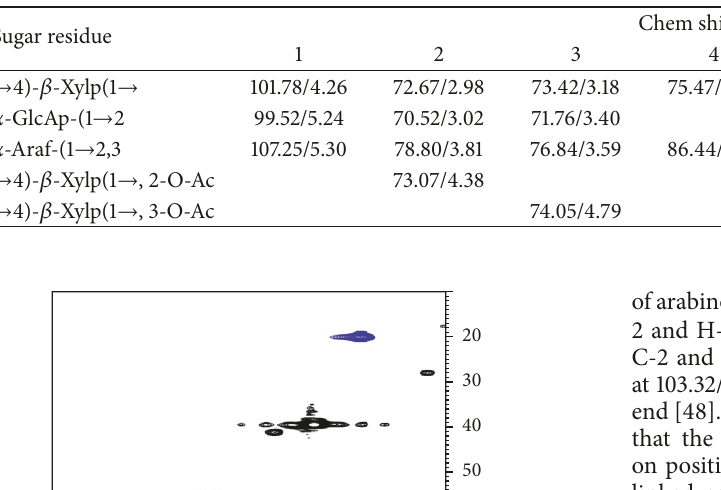
Table 3: 1 H and 13 C chemical shift (ppm) assignments for hemicellulosic fractions H 50 .